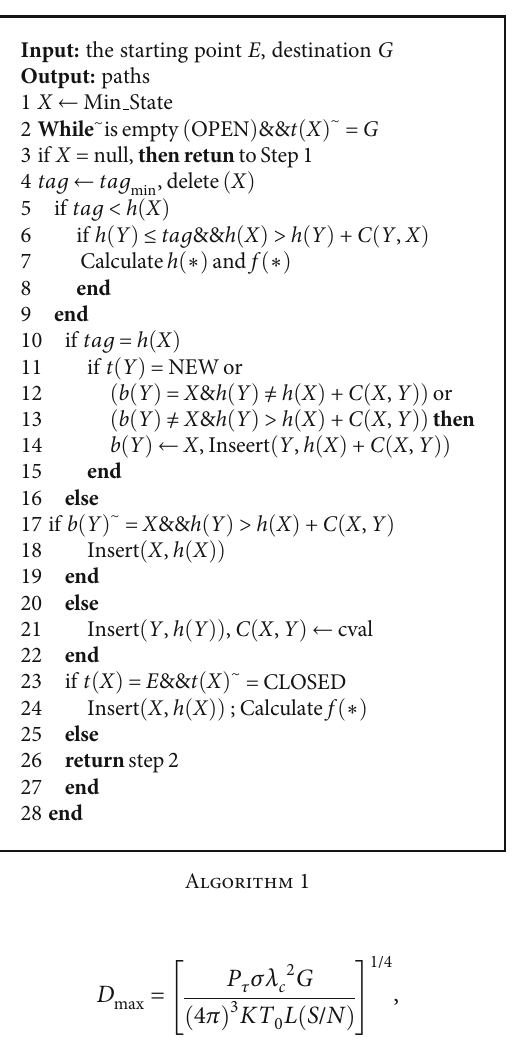
Figure 1: The con fi guration of the dual-base radar